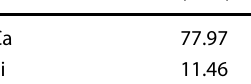
Table 1 Chemical composition of the WASP raw